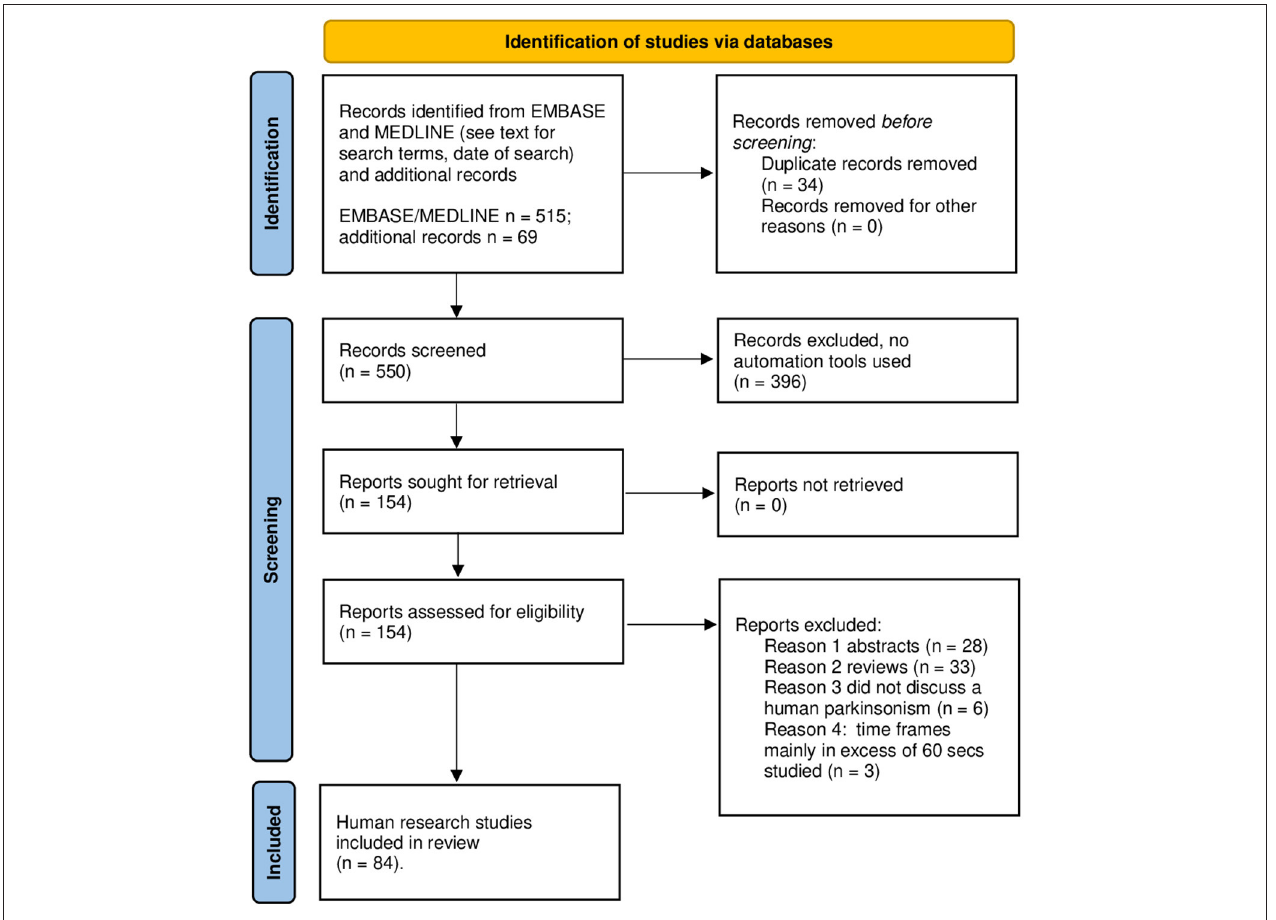
FIGURE 3 | PRISMA 2020 template for the search and selection strategy used in this review. Review of literature according PRISMA 2020 flow